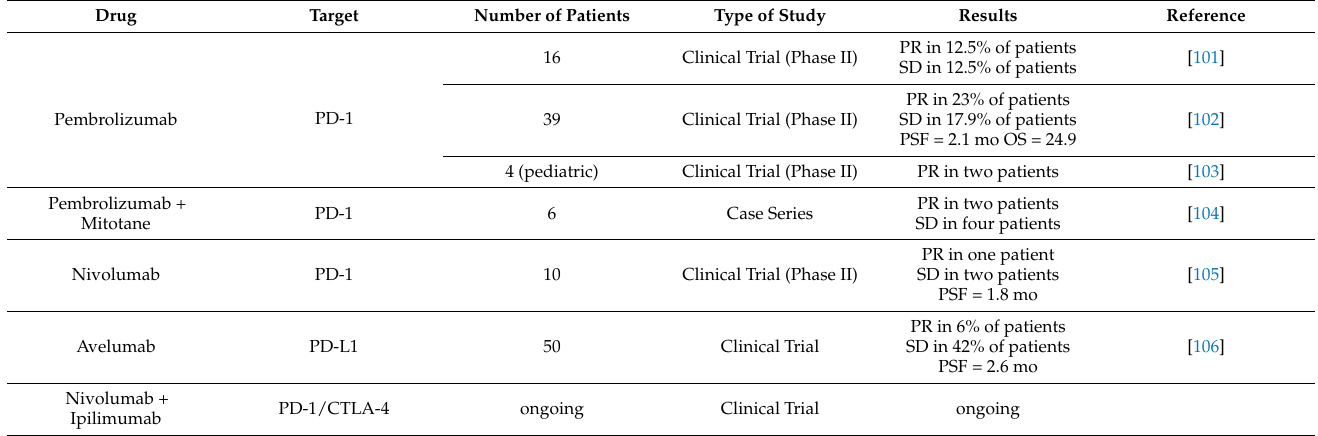
Table 1. Immunotherapy trials in